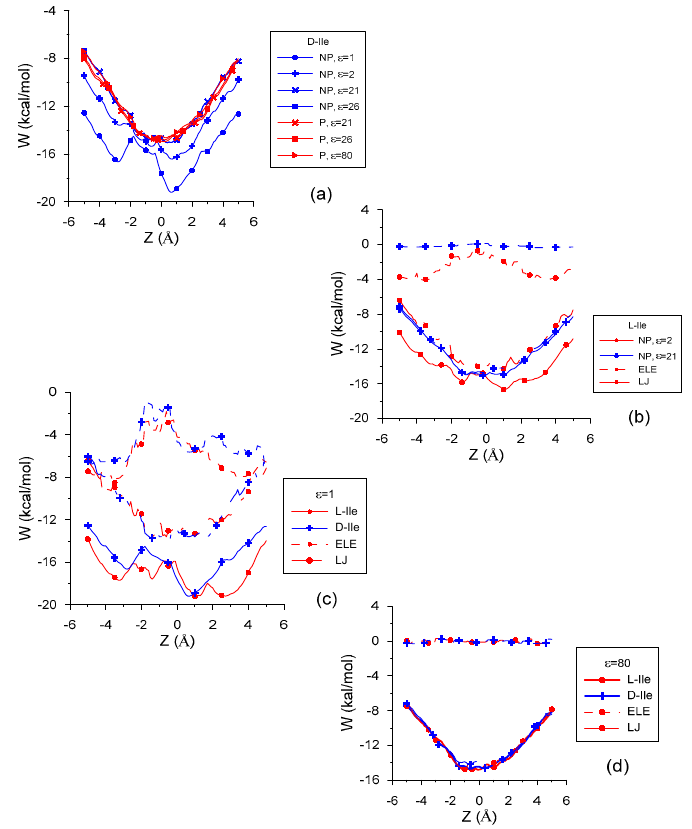
Figure 2. The penetration potential W and its different contributions for the interaction between β –CD and ( a ) D-Ile in vacuo and with different solvents; ( b ) L-Ile in non-polar solvents; ( c ) Ile enantiomers in vacuo; ( d ) Ile enantiomers with